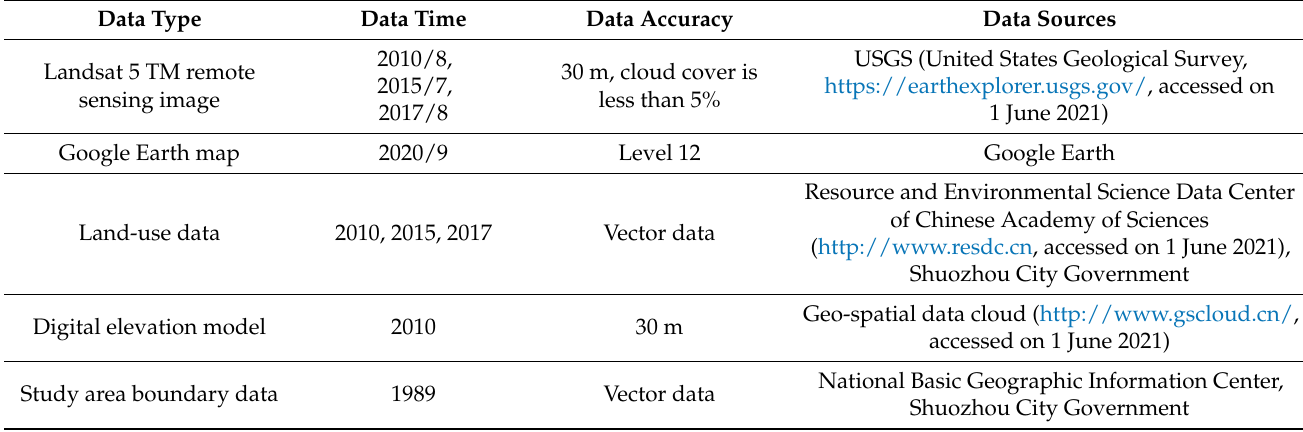
Table 1. Data sources and